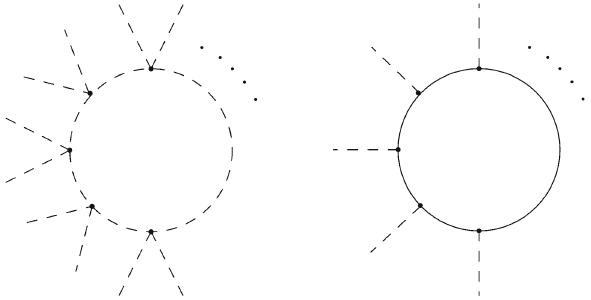
Fig. 3 Diagrammatic representation for the two contributions to the RG flow Eq. (33) of ˆ λ n in the DER and in the UV limit, where the rescaled Higgs quartic coupling ˆ λ 2 plays a dominant